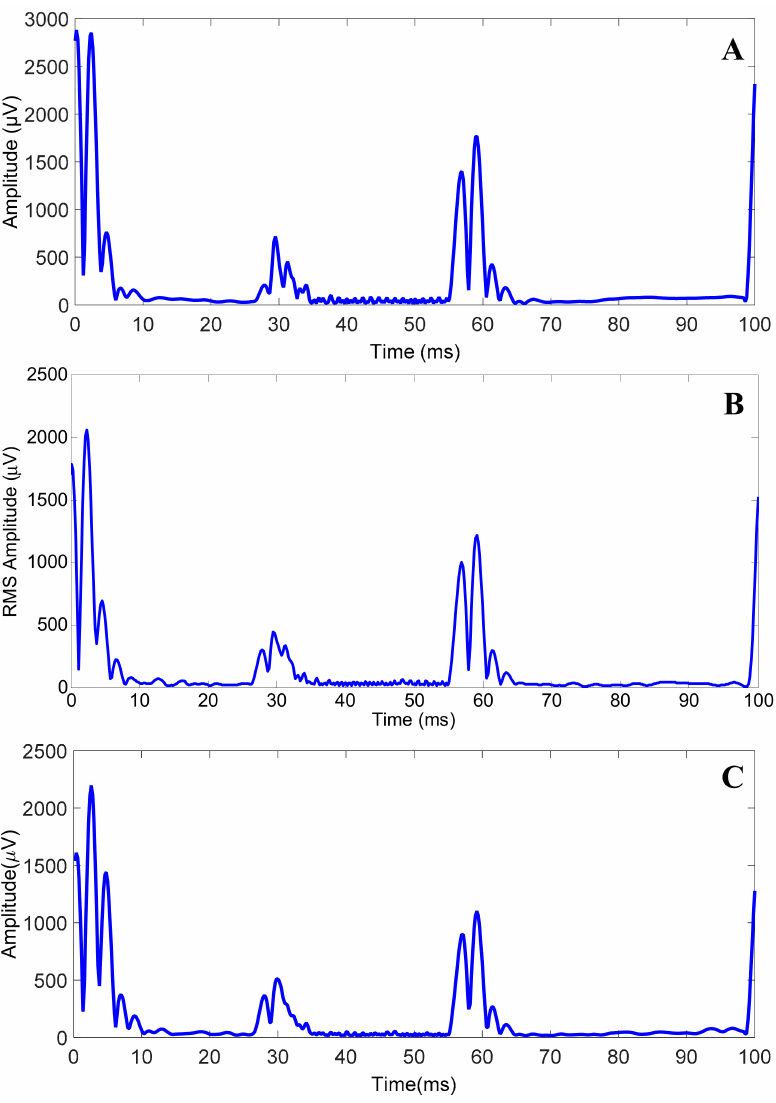
Figure 10. Variation of the average RMS amplitude of the GA over the channels with respect to time in the TR period for the human subjects ( A ), the head-shaped phantom ( B ), and the spherical phantom ( C